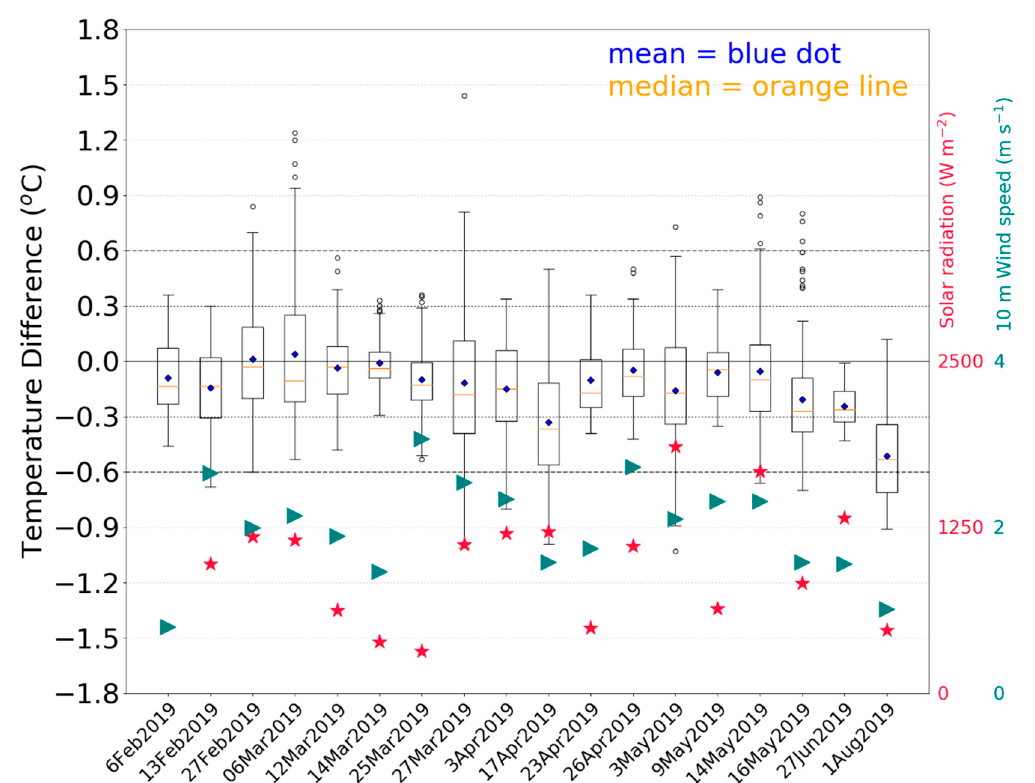
Figure 4. Boxplots of the temperature differences (°C) between each iMET-XQ and the 9.5 m tower sensor, by date, for the 18 flight experiments. The red stars represent relative solar radiation values, and the green triangles represent relative 10 m wind speed values averaged over the duration of each experiment. Actual values are given in Table 3. The outliers (open dots) are located beyond the edges of the whiskers which are determined by 1.5 times the inter-quartile range (IQR) beyond the first and third quartiles (the edges of the box). The mean and standard deviations for each flight experiment are listed in Table 4. The means are represented by blue dots, the medians are shown by orange lines. A temperature difference of 0.3 °C is marked by a dotted line. A temperature difference of 0.6 °C is marked by a dashed line. Table 4. Mean and standard deviations of temperature differences (TD, °C) between each iMET-XQ and the 9.5 m tower sensor, by date, for the 18 flight experiments.